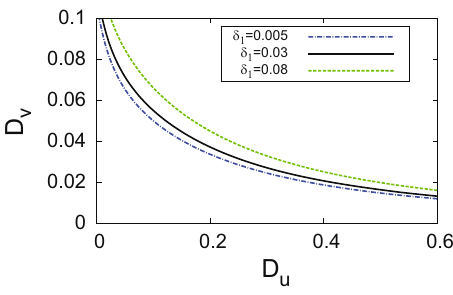
Figure 5: The D D − u v parameter plane shows the two - term hysteresis curve with